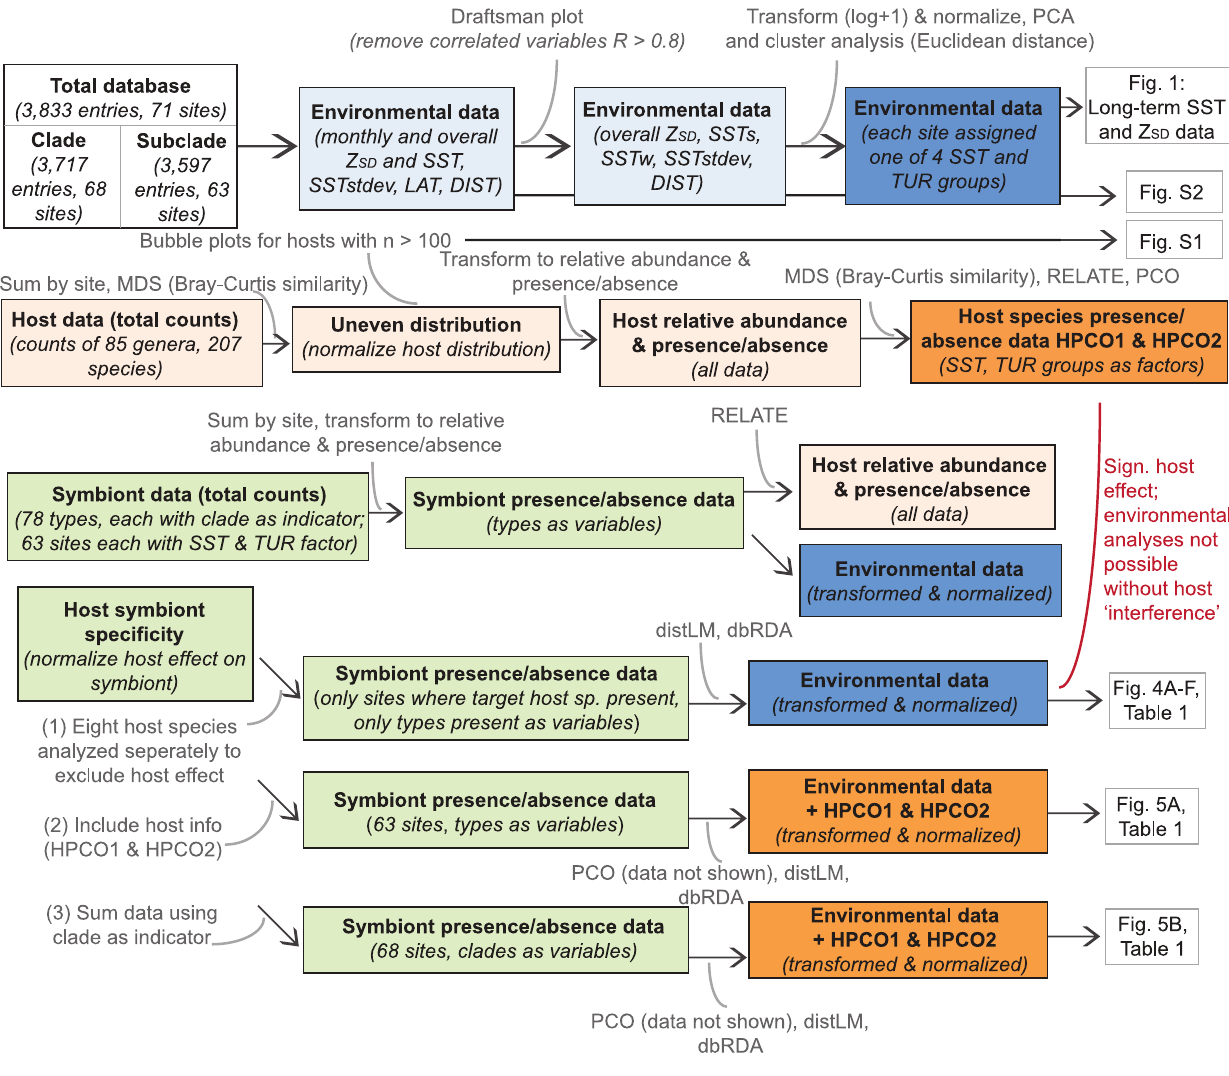
Figure 2. Flowchart of statistical analyses performed in PRIMER with PERMANOVA add-on.